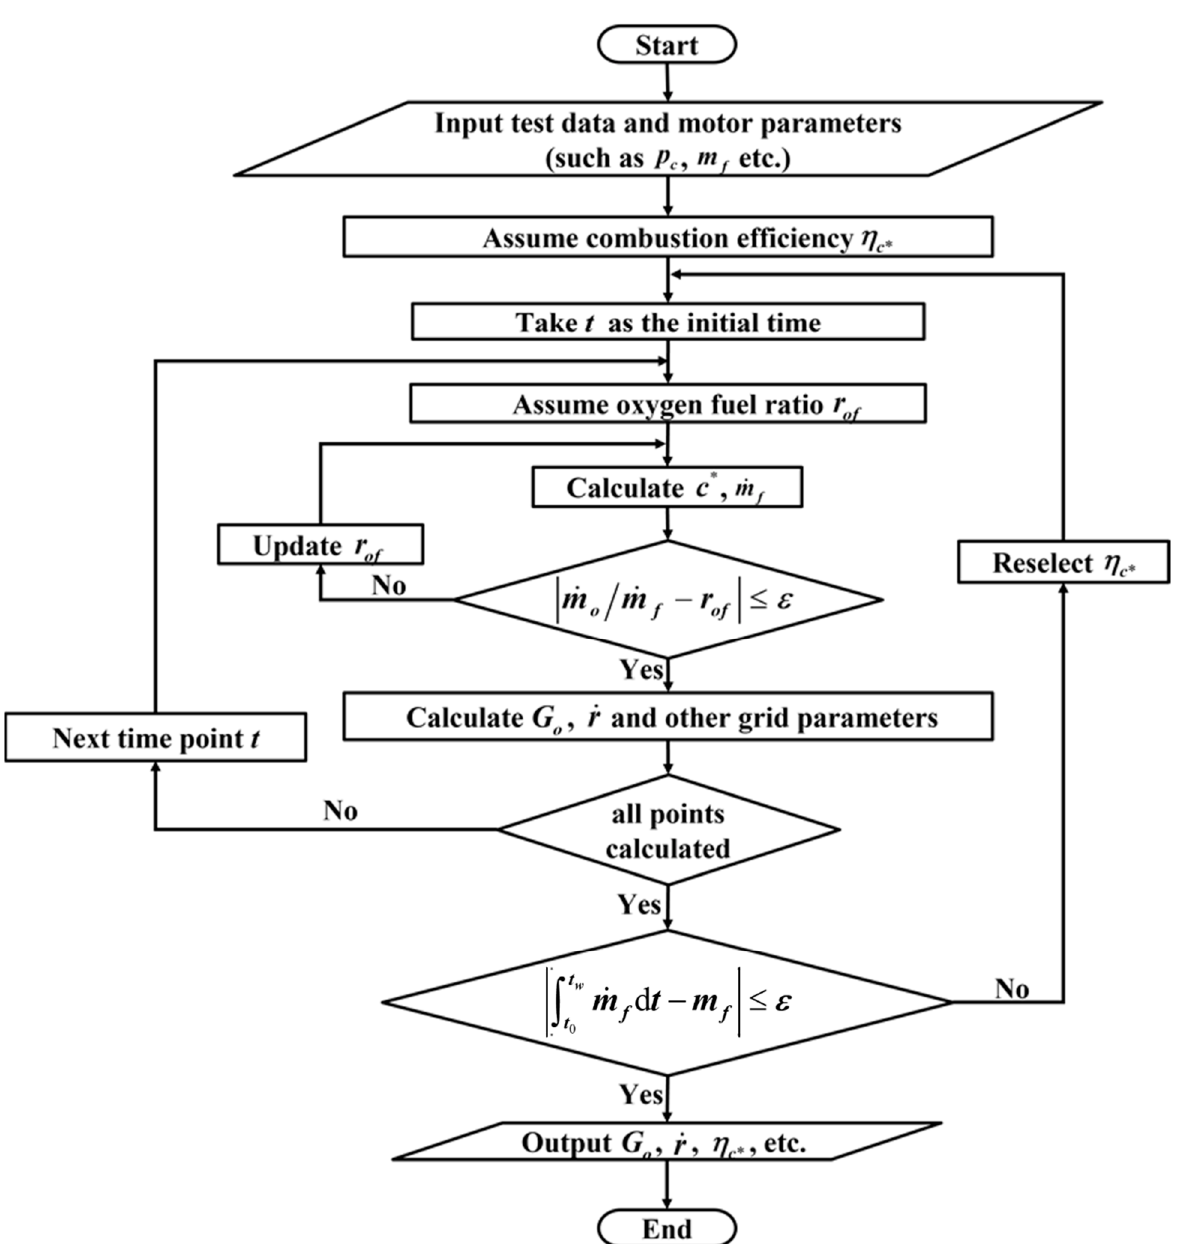
Figure 3. Flow chart for calculating instantaneous regression rate.